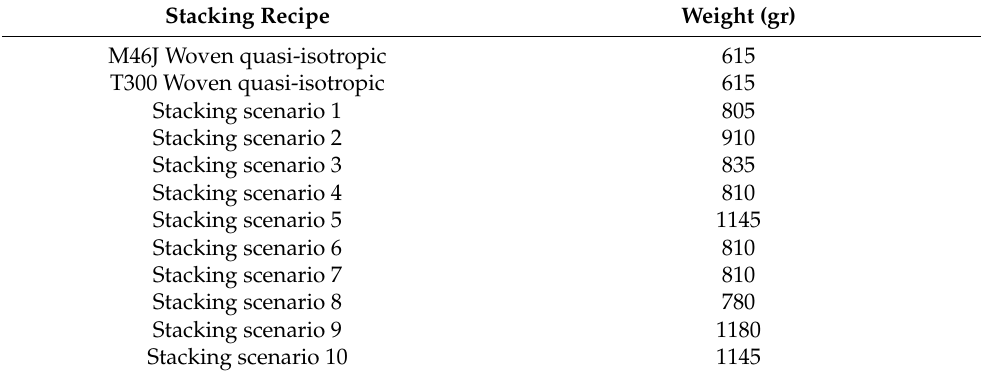
Table 29. Weight of each stacking